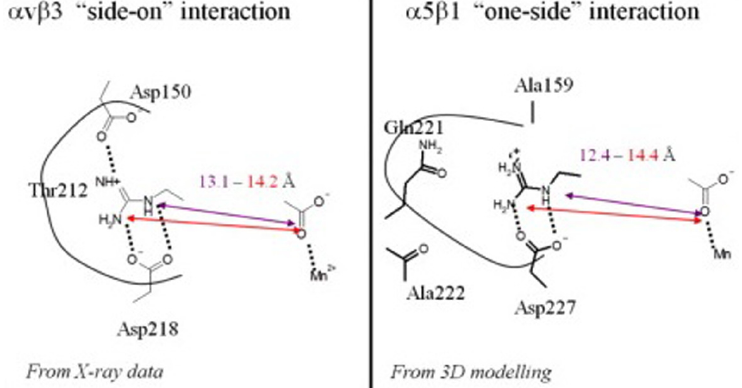
Figure 2. RGD interacting with integrins α v β 3 and α 5 β 3. Reprinted with permission from